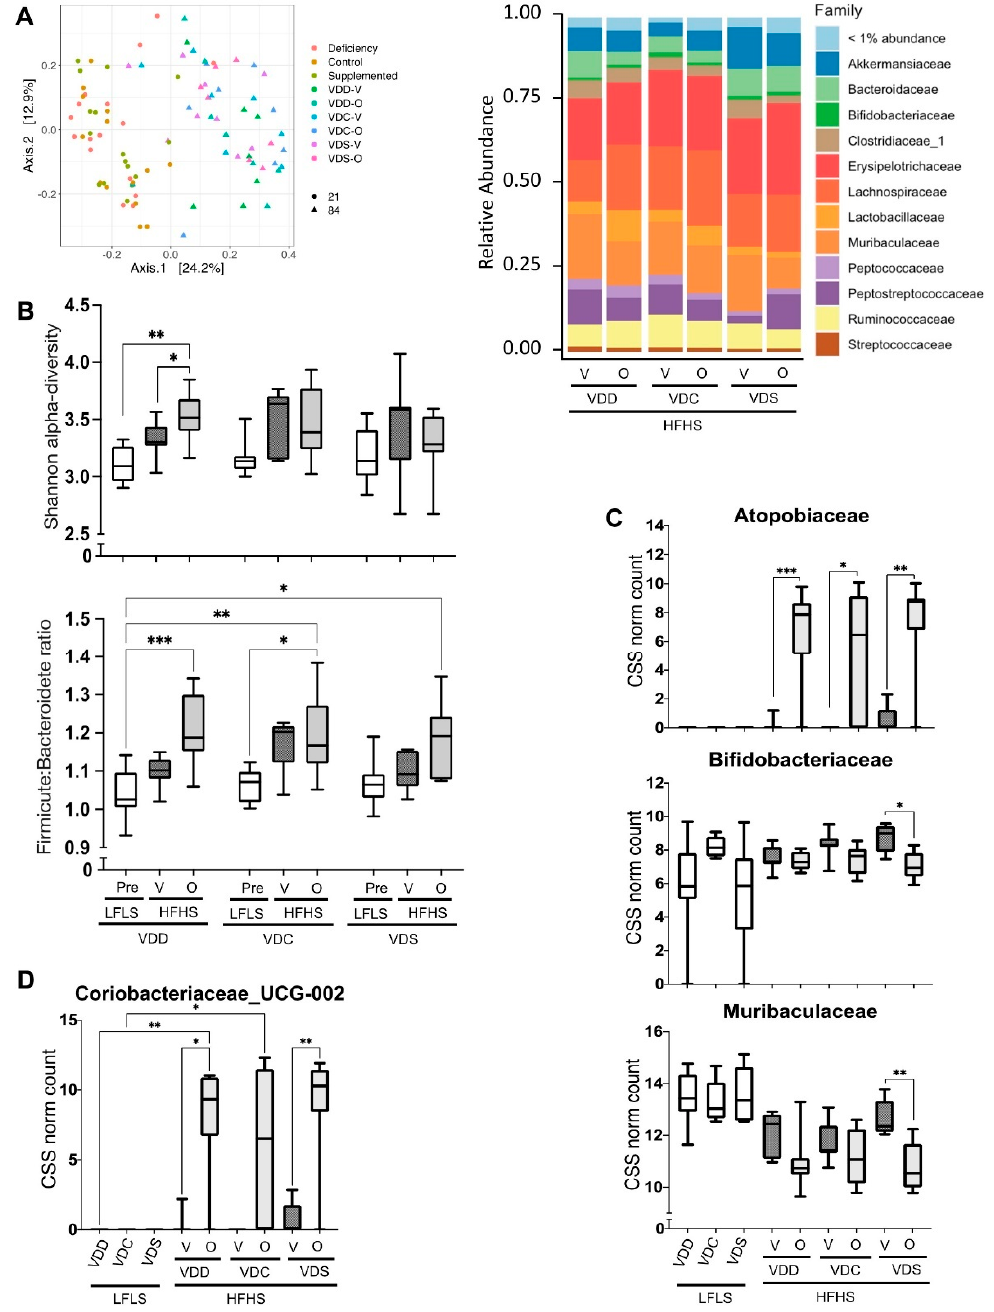
Figure 5. Composition of the faecal microbiome. ( A ) beta-diversity of gut microbiome composition through Principal Coordinate Analysis (PCoA; left ) and relative abundance of Families ( right ). ( B ) Shannon alpha-diversity index evaluating gut microbiota richness and evenness ( top ) and Firmicutes to Bacteroidetes ratio ( bottom ). Prevalence of selected gut microbiota at the ( C ) family and ( D ) genus level on days 21 (after LFLS) and 86 (after HFHS). Data are shown as box (5th and 95th and mean value) and whisker (minimum and maximum values) plots. * p ≤ 0.05; ** p ≤ 0.01;, *** p ≤ 0.005.